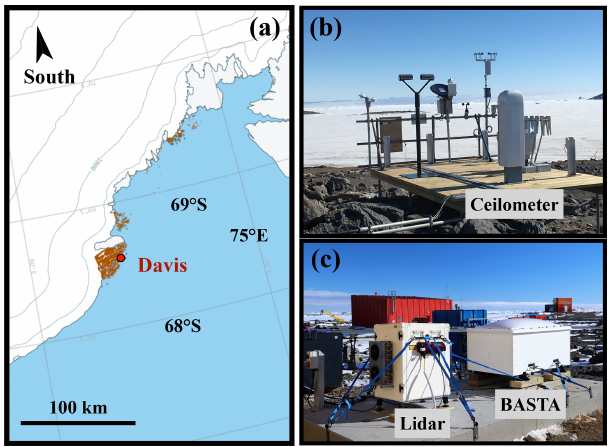
Figure 1. (a) Location of Davis in East Antarctica. The basemap was extracted from the Antarctic Digital Database from the Sci- entific Committee on Antarctic Research (SCAR) from the British Antarctic Survey. Rocky outcrops are shown in brown and elevation as contour lines every 500m. (b) Photograph of the Vaisala CL51 ceilometer (foreground) installed on the meteorological platform to- gether with other instruments not used in this study (credit: Andrew Klekociuk, Australian Antarctic Division). (c) Photograph of the W- band radar (BASTA) and the Raman depolarization lidar mounted on a dedicated concrete slab (credit: Simon Alexander, Australian Antarctic